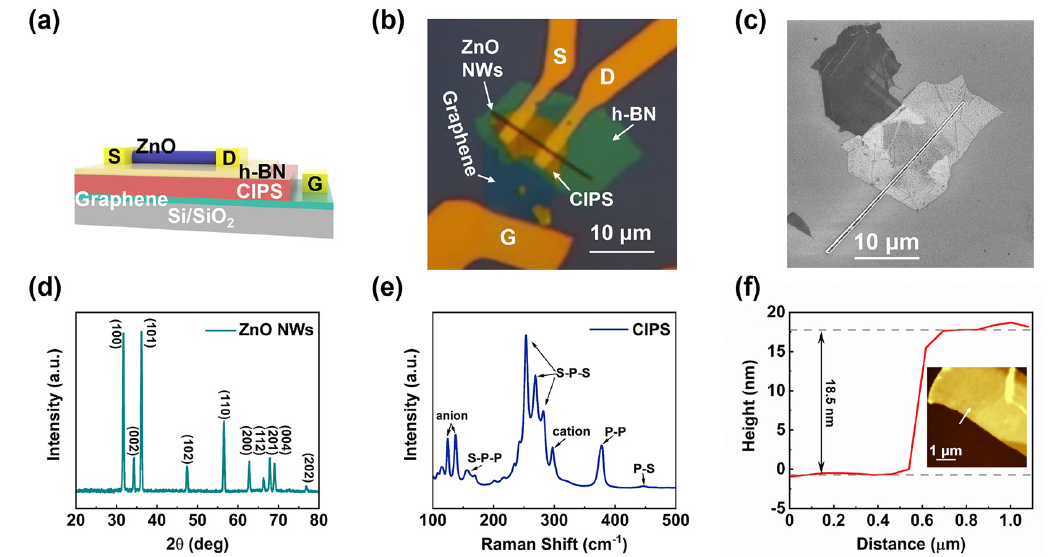
Figure 1. ( a ) Schematic diagram of the ZnO NW Fe–FET device structure, with an insulating layer of h–BN (yellow). ( b ) The optical image of the structure of the ZnO NW Fe–FET device. Graphene, CIPS, h–BN, and ZnO NWs were stacked sequentially; the graphene flakes were connected to the gate (G) electrode and the CIPS flakes; and the source (S) and drain (D) electrodes were connected to both ends of the ZnO NWs. ( c ) SEM image of ZnO NW Fe–FET device before electrode deposition. ( d ) XRD patterns of the ZnO NWs. ( e ) Raman spectra of CIPS flakes. ( f ) Thickness data of CIPS flakes along the white arrow in the AFM